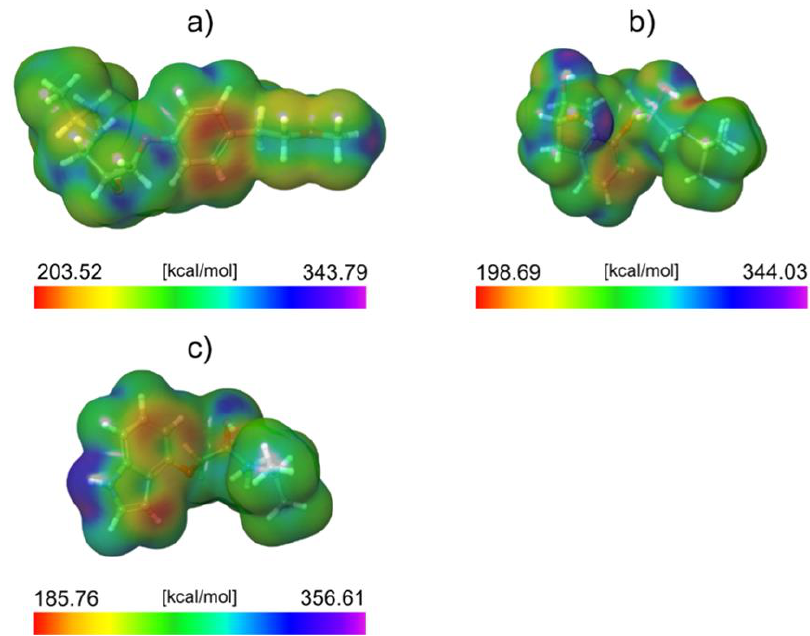
Figure 11. ALIE surfaces of ( a ) MET, ( b ) NAD, and ( c )